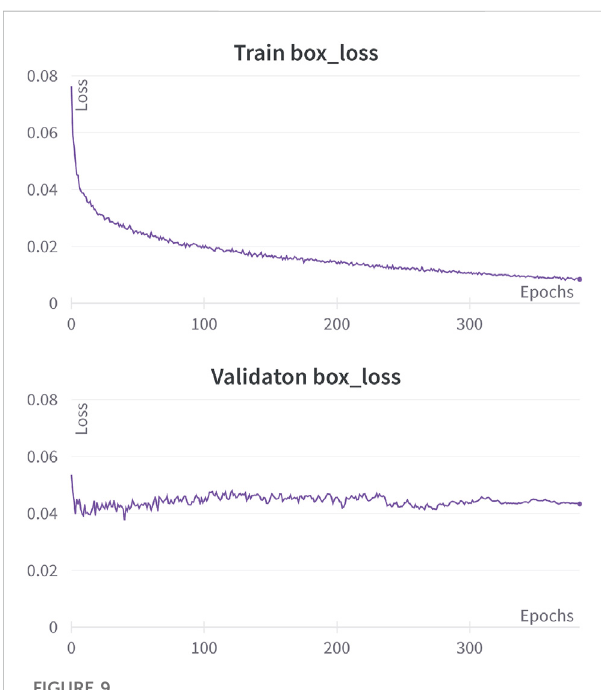
FIGURE 11 Training and validation performances in the box loss function during 31